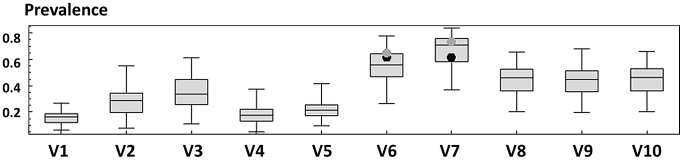
SWB model validation: prediction of 2009 village-level S. haematobium prevalence among school-age children.Following initial calibration of the programmed SWB model against human and snail S. haematobium prevalence data from 1983–1987 and 2000–2006 [22], we checked the predictive accuracy of the model against new survey data obtained for two study villages in 2009 after a round of community-wide treatment in 2006. The observed S. haematobium prevalence among school-age children (y-axis) is indicated by black dots for villages 6 and 7. The corresponding gray dots indicate the predictions of the model for these two villages using the model's best-fit parameter values. The box-plots indicate the median, interquartile range, and 95% range of the SWB model predictions in sensitivity analysis, in which model input parameters were allowed to vary at random over a ±20% range. The concordance between observed and predicted values in this and other validation testing [22] provided support for the accuracy of model projections in the present study simulations.